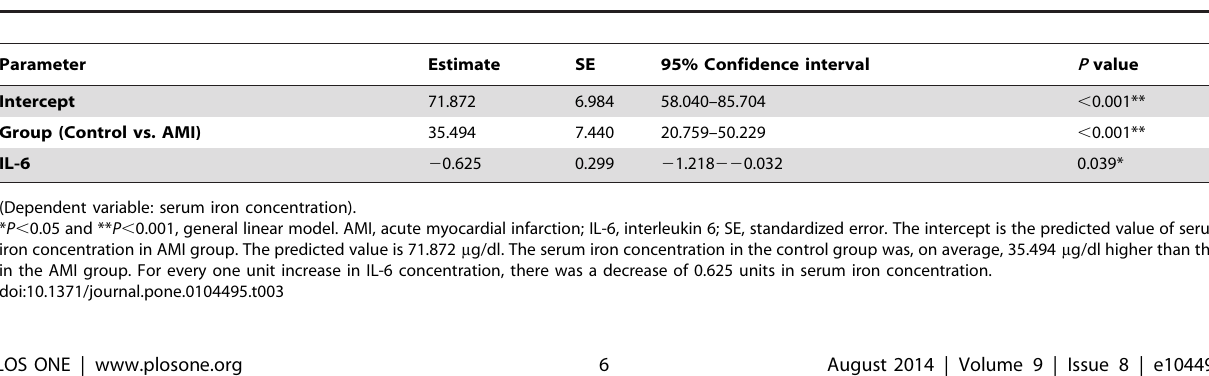
Table 3. The relationship between serum iron and interleukin-6 levels in all subjects.